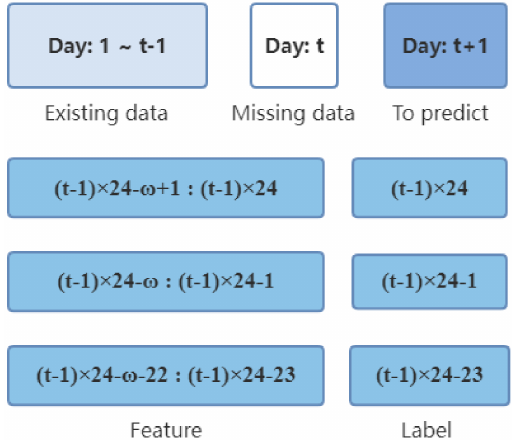
Figure 1. Data sample form of day-ahead load